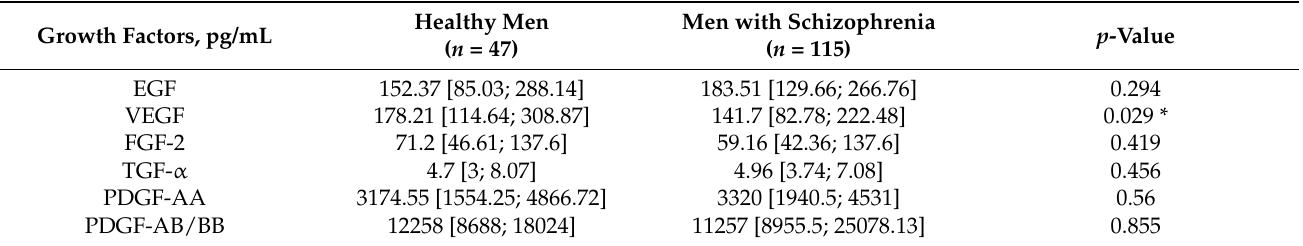
Table 3. Concentration of serum growth factors in male patients with schizophrenia and healthy persons (Me [Q1; Q3]).